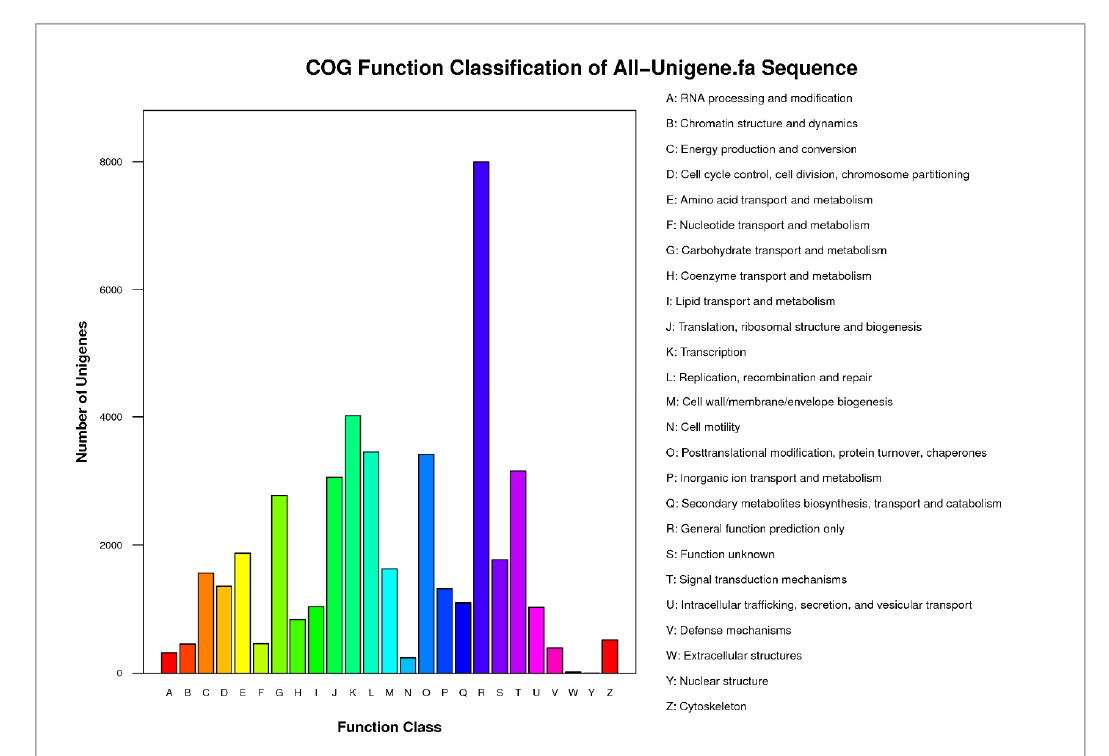
Figure 3. Histogram representation of clusters of orthologous groups (COG). The horizontal coordinates are function classes of COG, and the vertical coordinates are numbers of unigenes in one class. The notation on the right is the full name of the functions in the x -axis. Histogram representation of classification of the clusters of orthologous groups (COG) for the total aligned 43,780 unigenes (53.43%) into 25 functional groups. Diversity 2021 , 13 , x FOR PEER REVIEW